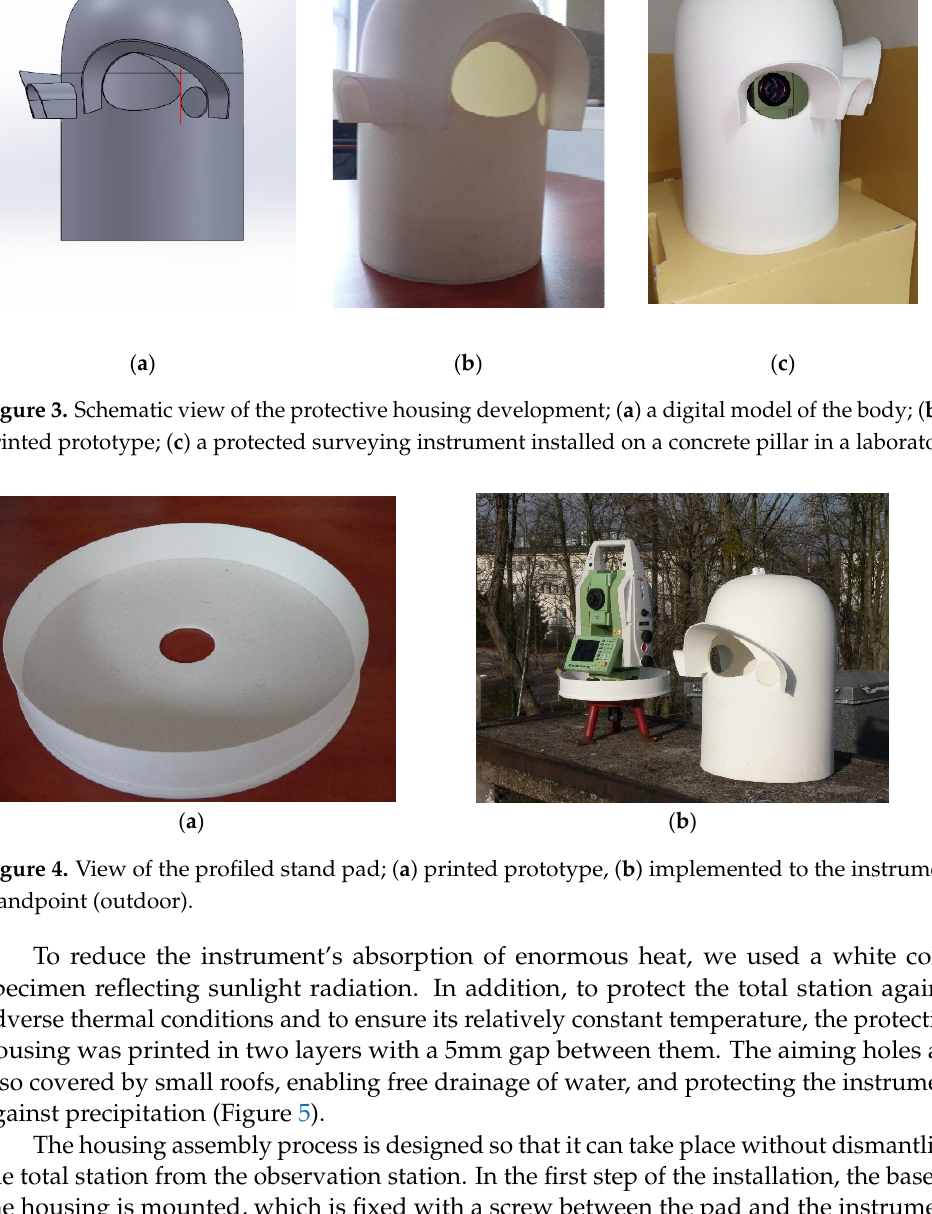
Figure 4. View of the profiled stand pad; ( a ) printed prototype, ( b ) implemented to the instrument standpoint (outdoor).